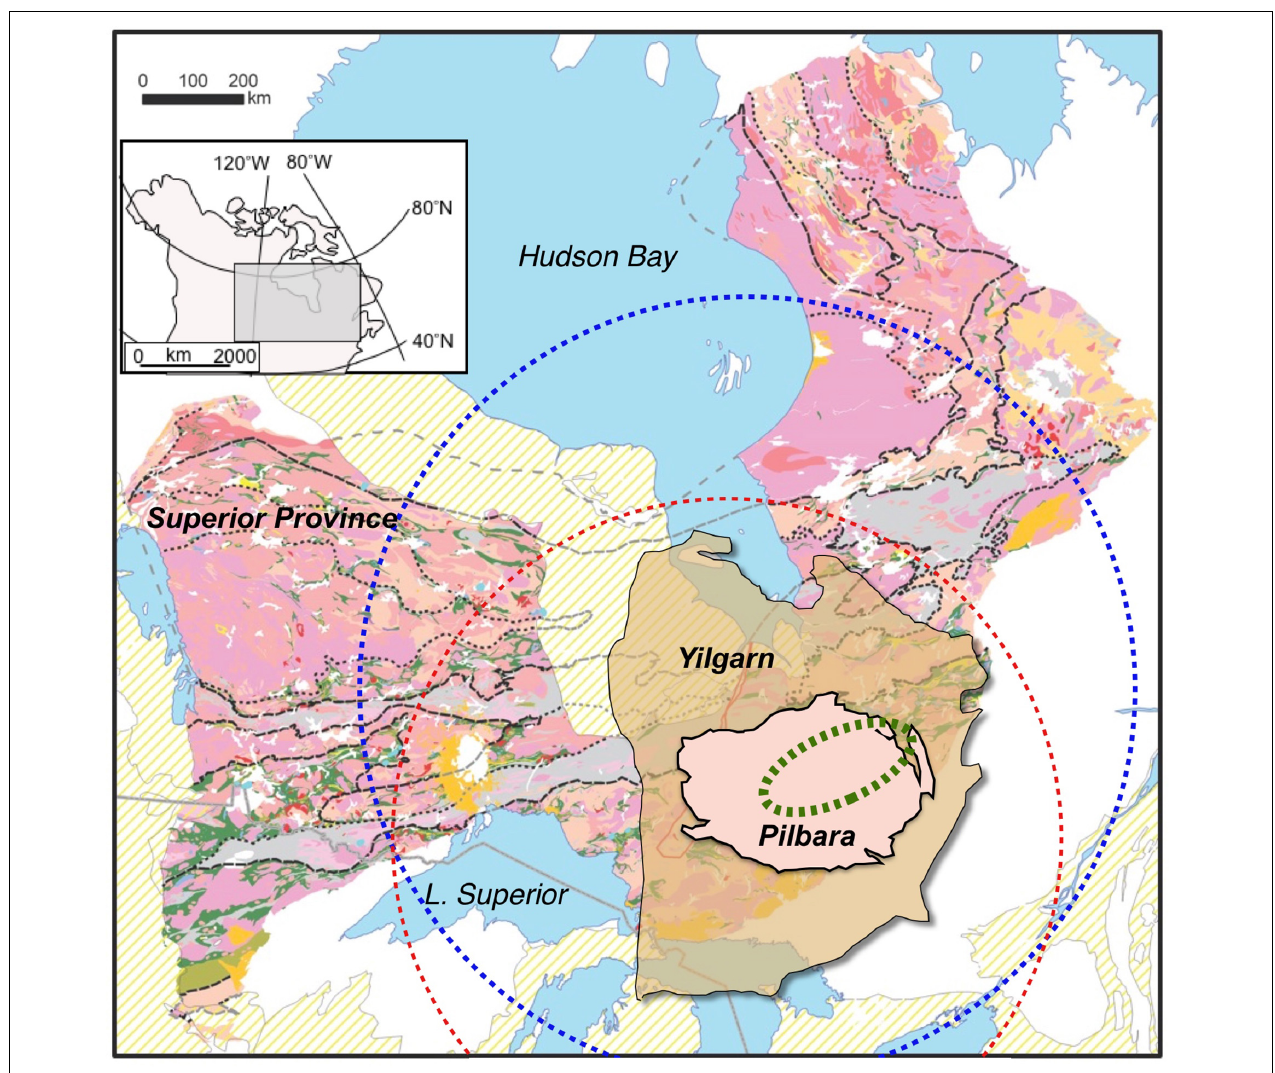
FIGURE 1 | A comparison of the Superior Province, Yilgarn Craton and Pilbara Craton showing the approximate sizes of mantle plume heads as inferred by Mole et al. (2014) for the Yilgarn ∼ 2900 (blue circle) and ∼ 2700 Ma (red circle) plumes and Dostal and Mueller (2013) for the Abitibi. The Abitibi plume is shown as a green dashed ellipse, based on the plume head shape implied in Dostal and Mueller (2013). No size estimates are available for the suggested eight mantle plume events of the 3530–3230 Ma Pilbara Supergroup inferred by Hickman and Van Kranendonk (2012). The historically inferred size of Yilgarn mantle plume heads is inconsistent with Superior Province geological field relations or the Archean plume events ascribed to the craton. See text for a discussion of the plume size estimates. Areas marked with yellow diagonal lines are overlain by Phanerozoic sedimentary cover. Superior Province map from Percival et al. (2012). Location of the Superior Province Craton is shown in the inset. The locations of the Yilgarn and Pilbara Cratons are shown in Figure 3